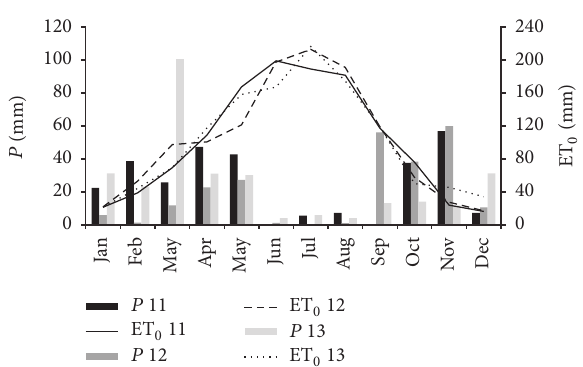
Figure 1: Monthly rainfall ( 𝑃 ) and reference evapotranspiration (ET 0 ) for the 3 years of the